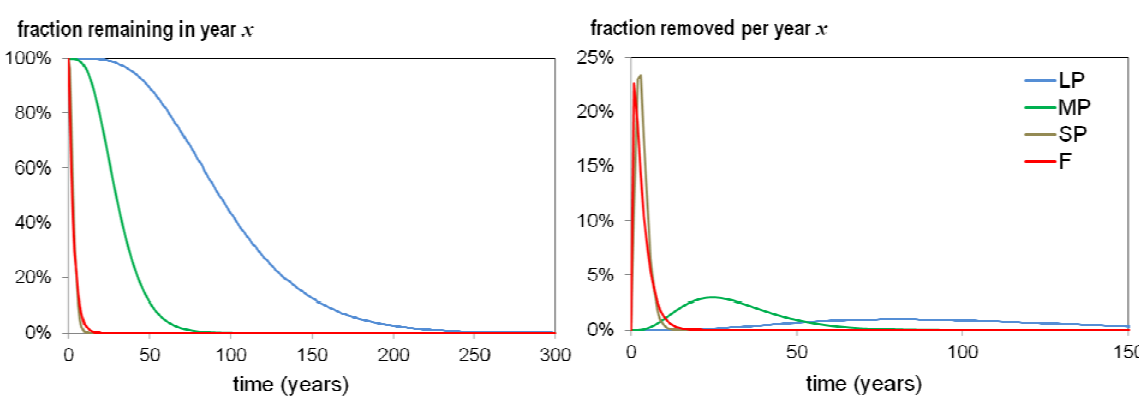
Figure 3. Fraction remaining and removed with time for the four different wood product classes; LP = products with long lifetime, MP = products with medium lifetime; SP = products with short lifetime, F = fuel